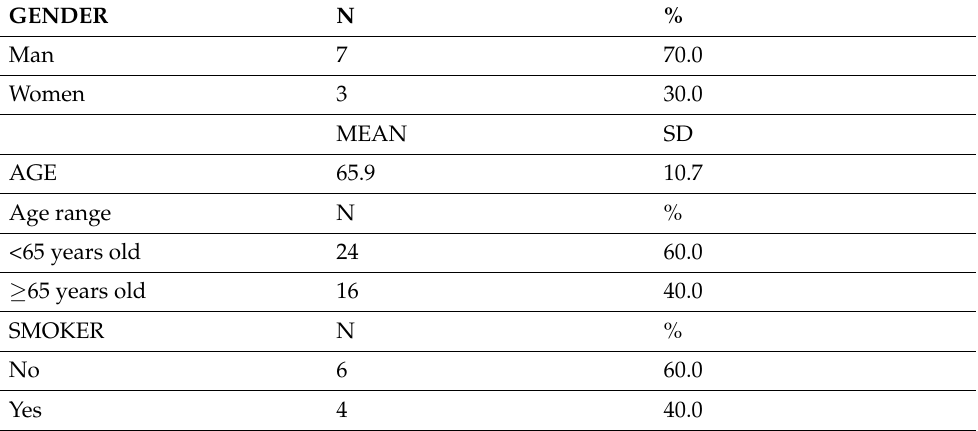
Table 1. Description of the sociodemographic and clinical characteristics of the edentulous patients participating in the study ( n =